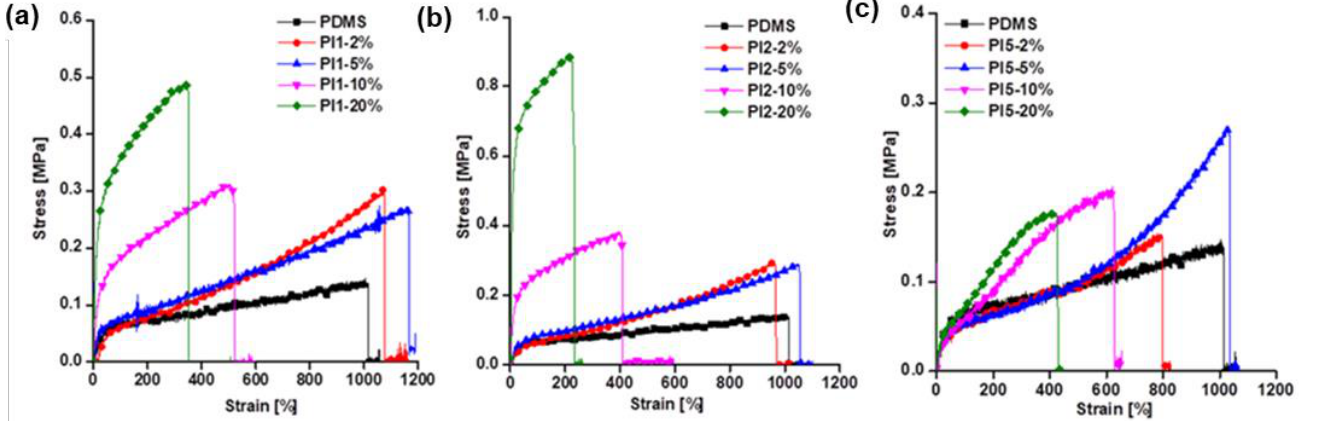
Figure 4. Mechanical stress-strain curves for ( a ) PI1, ( b ) PI2 and ( c ) PI5 composite series reported to reference sample, PDMS